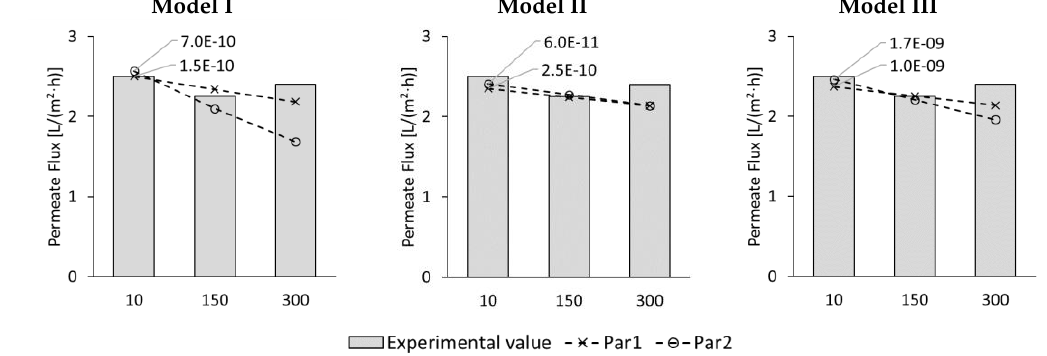
Figure 7. ALDS permeate flux of test series A5 for 10. 150, and 300 min test time from experiments (columns) and Model I, Model II, and Model III with membrane parameter set Par1 (dashed line with crosses) and Par2 (dashed line with circles). Modelled results are shown for best-fitting diffusion coefficient which is indicated next to the corresponding line.